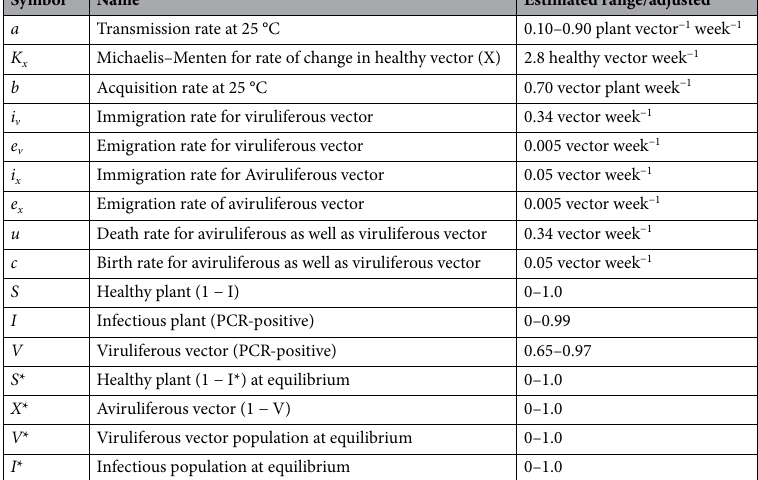
Table 2. Model parameters and variables used for leaf curl epidemic analysis in chili.